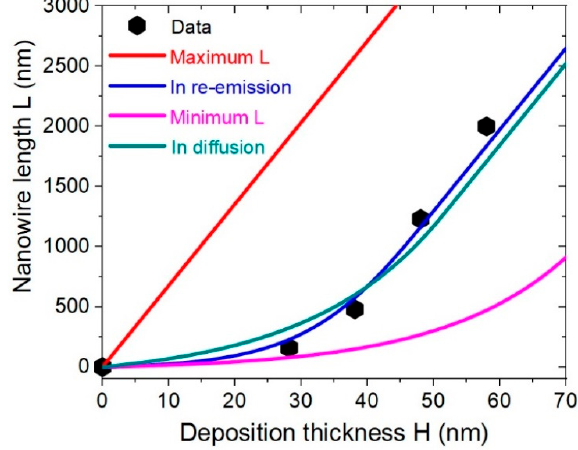
Figure 5. Length of an Au-catalyzed, 12 nm radius InP NW versus the deposition thickness. Symbols represent the data of Ref. [31]. The blue line is the fit obtained within the growth model of Ref. [35] for the reflecting substrate assuming the Lambertian scattering of In atoms from the oxide mask. The green line is the best fit obtained from Equations (18) and (21).